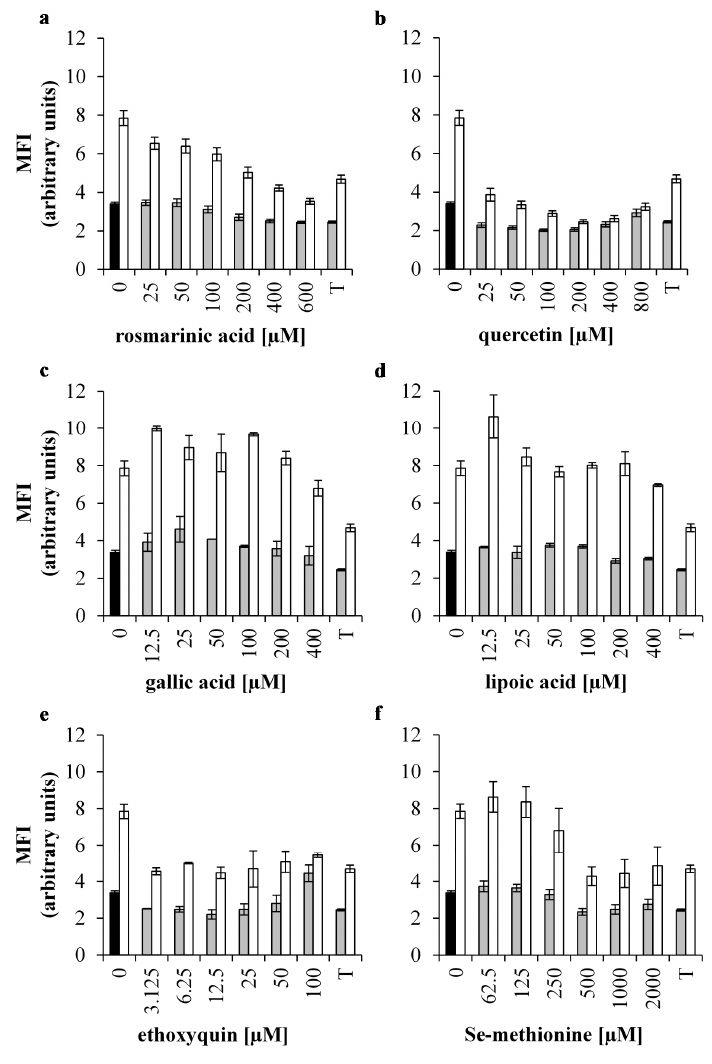
Figure 2. Intracellular oxidative stress of H 2 O 2 treated IPEC-J2 cells pre-treated with antioxidants. Generation of intracellular reactive oxygen species (iROS) is reported as mean fluorescent intensity (MFI) and measured in unstressed and H 2 O 2 treated IPEC-J2 cells ( black bar: untreated control cells, grey bars: no incubation with oxidative stress; white bars: cells stressed by 1 mM H 2 O 2 ) after treatment with ( a ) RA, ( b ) Que, ( c ) GA, ( d ) LA, ( e ) ETQ and ( f ) SeMet. All antioxidant pre-treatments were compared with 2 mM Trolox (T). Results are presented as means ± S.E., n = 2.